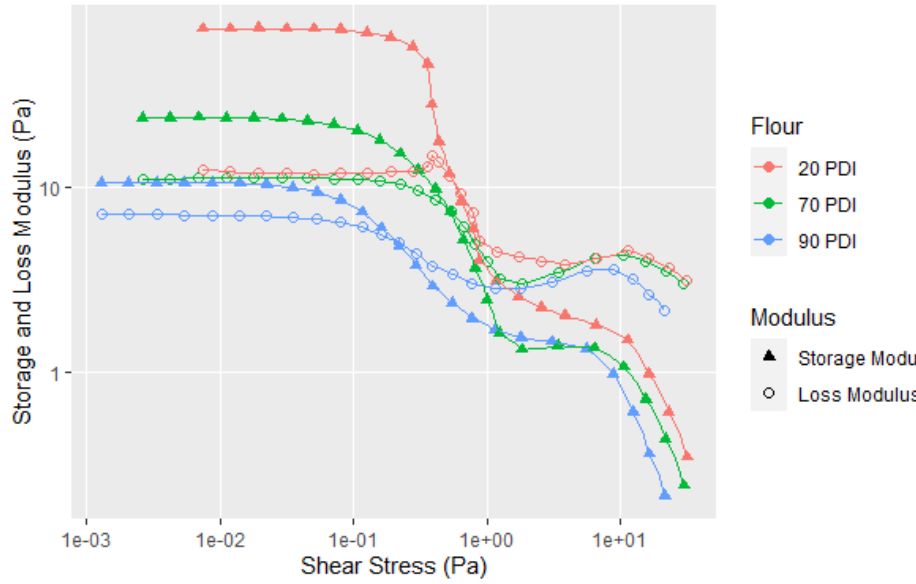
Figure 8. Amplitude sweep data for 20, 70, and 90 PDI flour at 30% solids. Single replicates shown (not average). All replicates shown in A7.